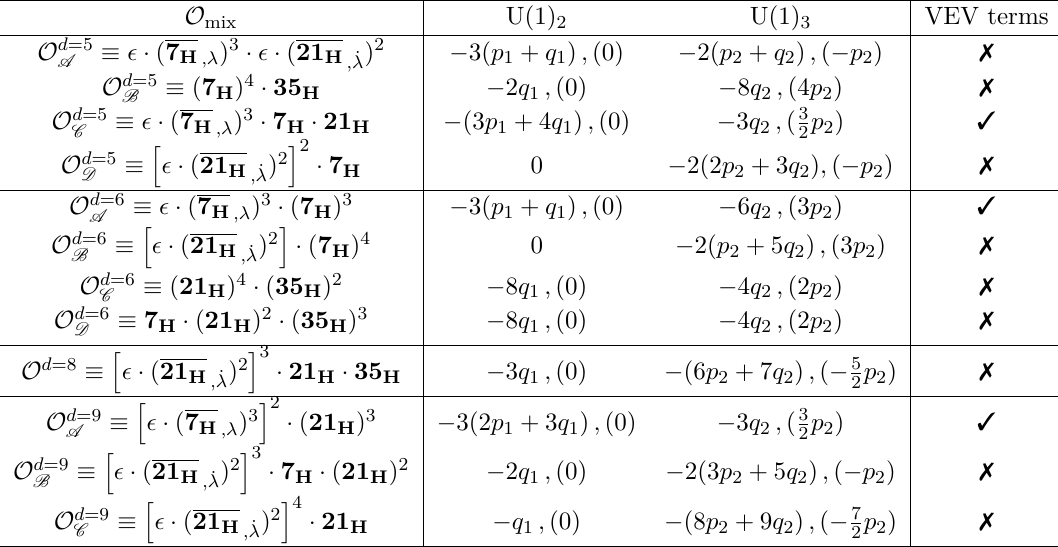
Table 9 . The non-renormalizable SU(7) Higgs mixing operators and their U(1) 2 , 3 charges. The 3 and 7 represent whether the specific operator can contribute to VEV terms in the Higgs potential or not. The charge assignments with p